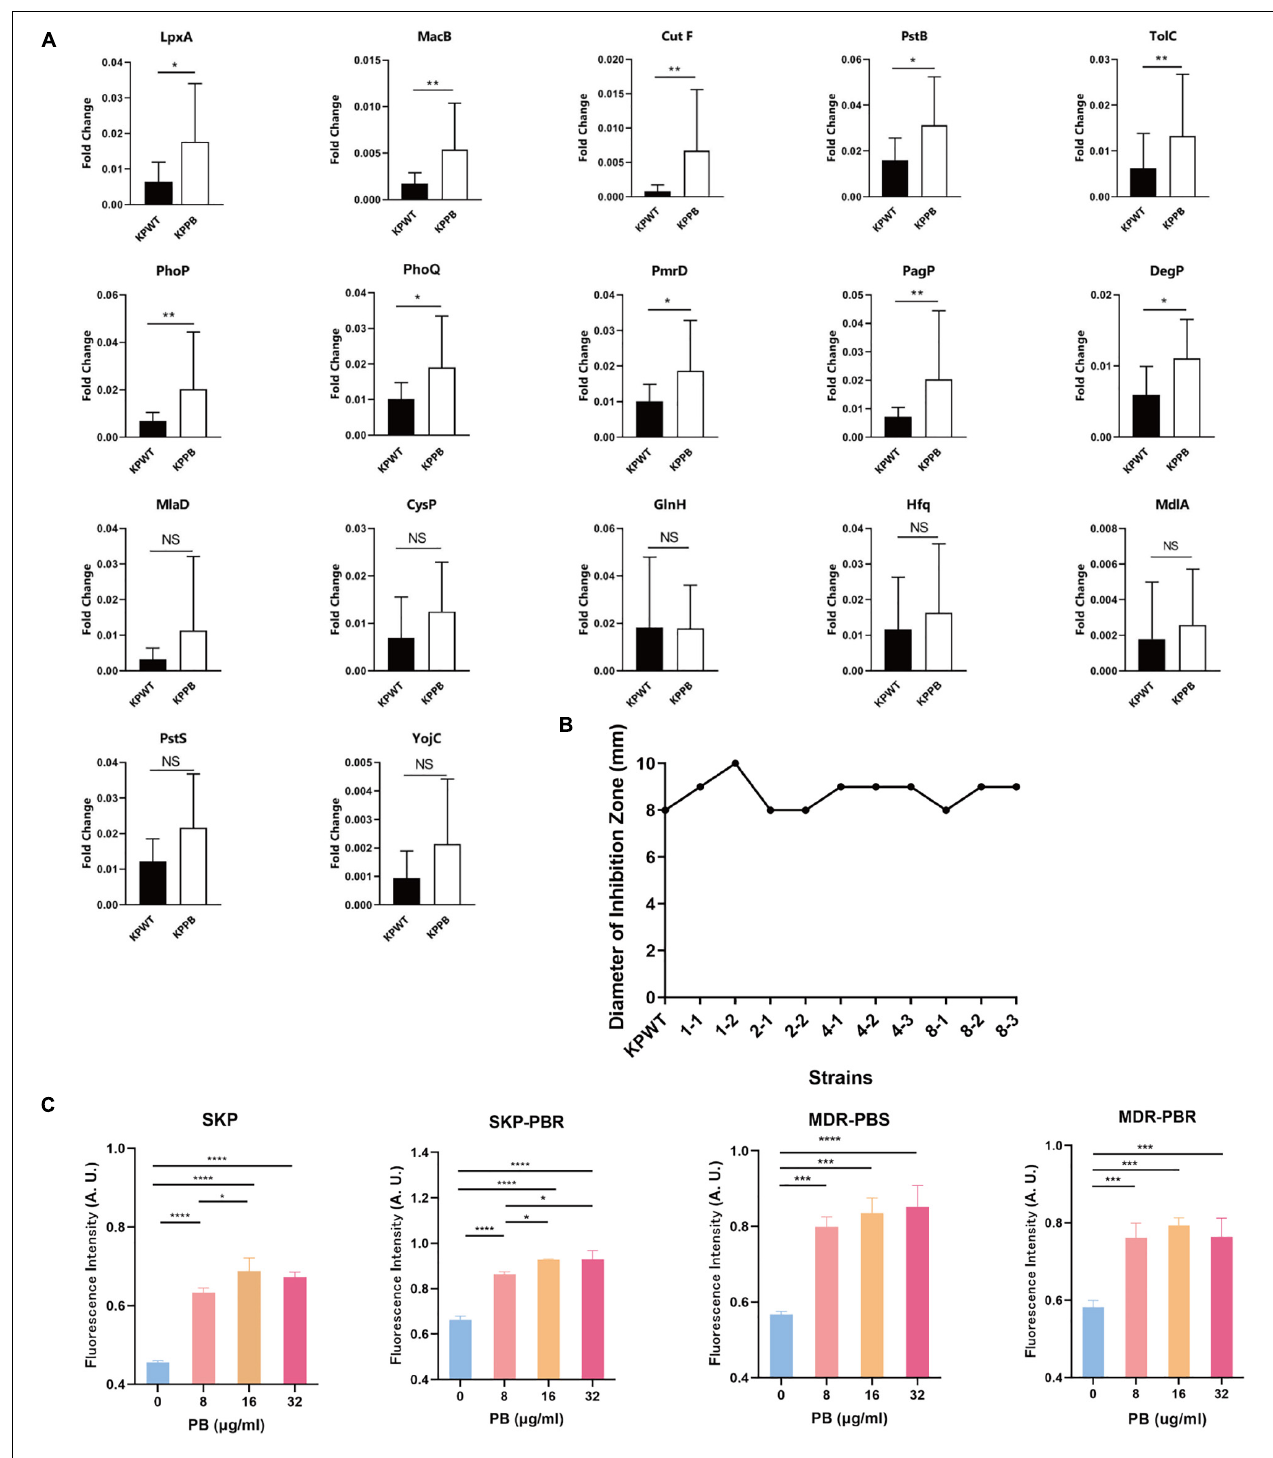
FIGURE 5 | Validation of proteomic results in Klebsiella pneumoniae . (A) Relative transcript levels of the selected genes in the PB-resistant and susceptible K. pneumoniae ( n = 10). NS, no significance. (B) Diameter of inhibition zone of erythromycin disk against K. pneumoniae . (C) Measurement of ROS production in K. pneumoniae clinical isolates treated with PB. SKP, K. pneumoniae susceptible to all first-line antibiotics; SKP-PBR, K. pneumoniae only resistant to PB; MDR-PBS, clinical isolate only susceptible to PB and tigecycline; MDR-PBR, PB-resistant strain only susceptible to tigecycline. Results are presented as the mean ± standard deviation. * P < 0.05, ** P < 0.01, *** P < 0.001, and **** P < 0.0001.